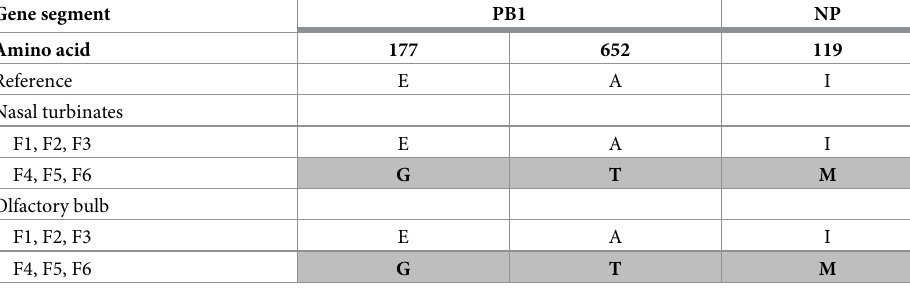
Table 4. In vivo stability of molecular signatures for CNS-mutations’ sites at 3 dpi. Gene